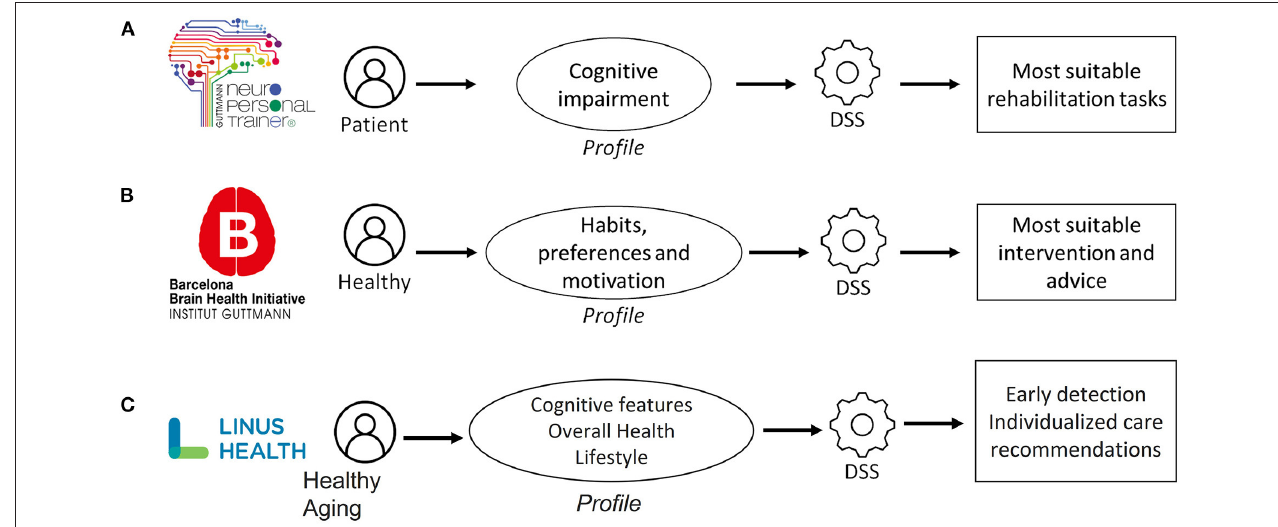
FIGURE 1 | Specific frameworks that illustrate the applied use of digital technologies to expand the reach of the clinician, while sustaining the personal connection between each patient and their clinician. (A) Intelligent technology therapy assistant (ITA) “Guttman Neuro Personal Trainer” ® ; (B) Barcelona brain health initiative (BBHI) stage 3 coaching app; (C) linus